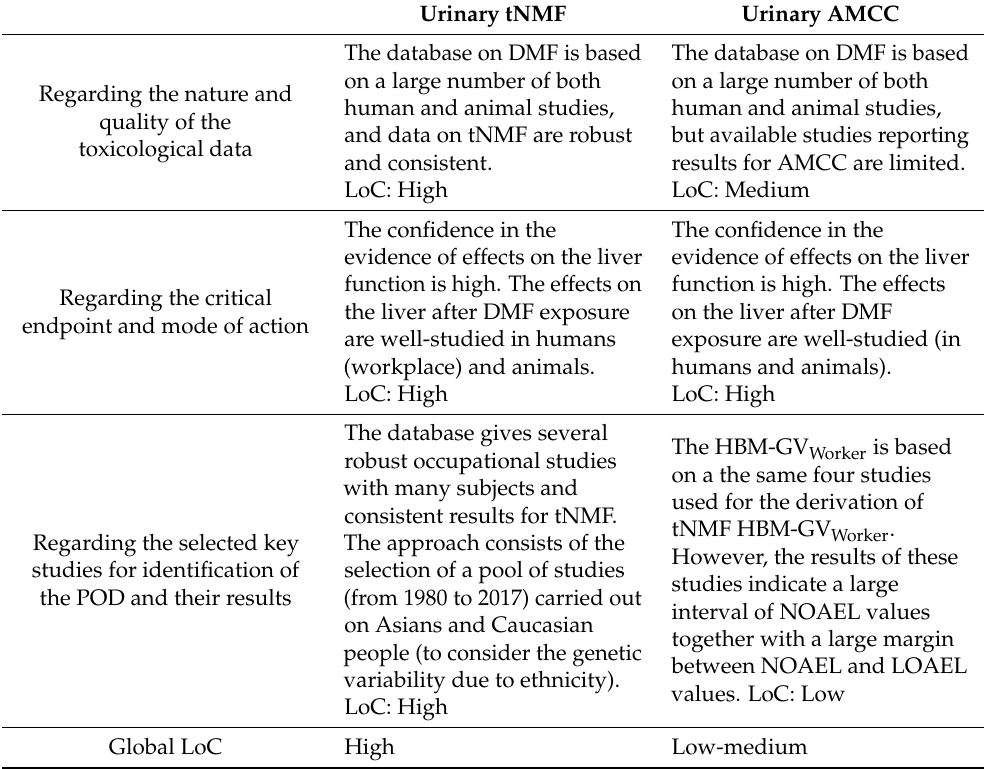
Table 5. Level of Confidence (LoC) regarding HBM-GV Worker recommended for urinary tNMF and